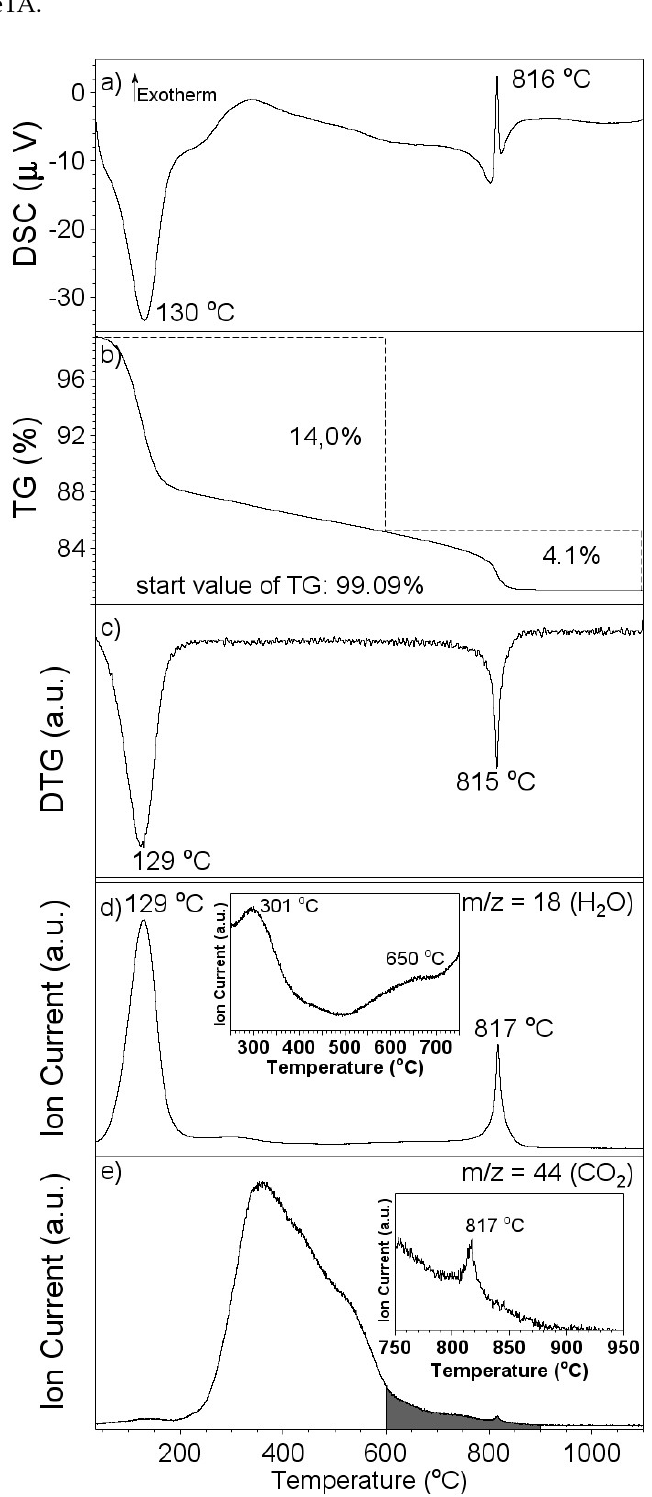
Figure 4. STA measurement of the clay fraction under SynA/N 2 : ( a ) DSC curve; ( b ) TG curve; ( c ) DTG curve; ( d ) MS curve of H 2 O; and ( e ) MS curve of CO 2 .